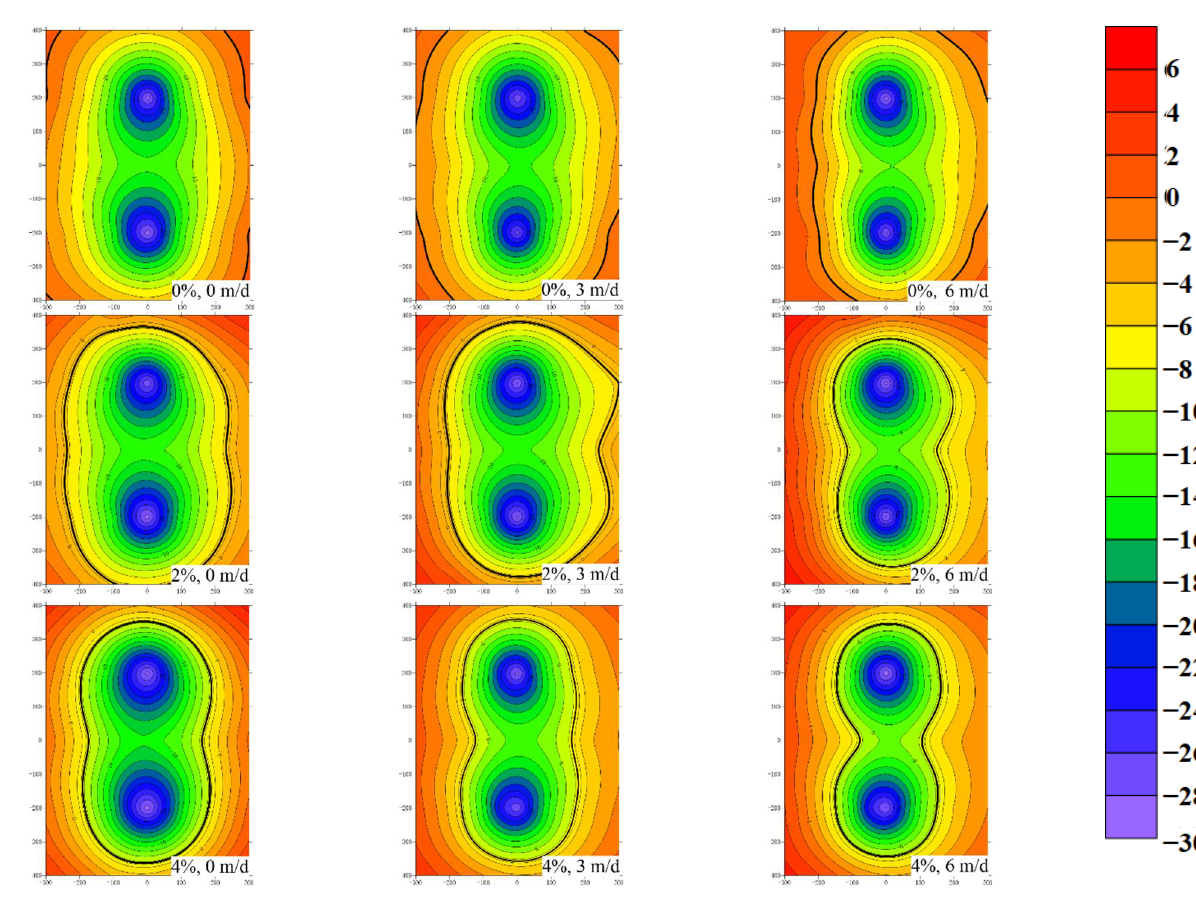
Figure 8. The temperature distribution of freezing for 32 h under different test conditions.